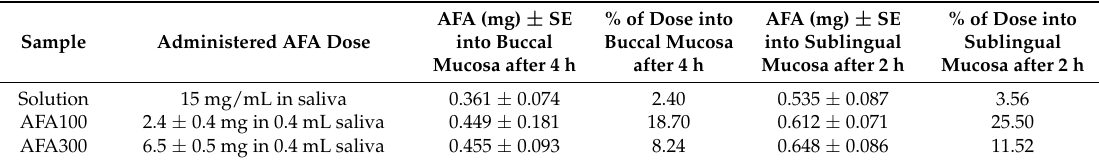
Table 5. Results of AFA entrapment in buccal and sublingual mucosae after administration of solution and films.